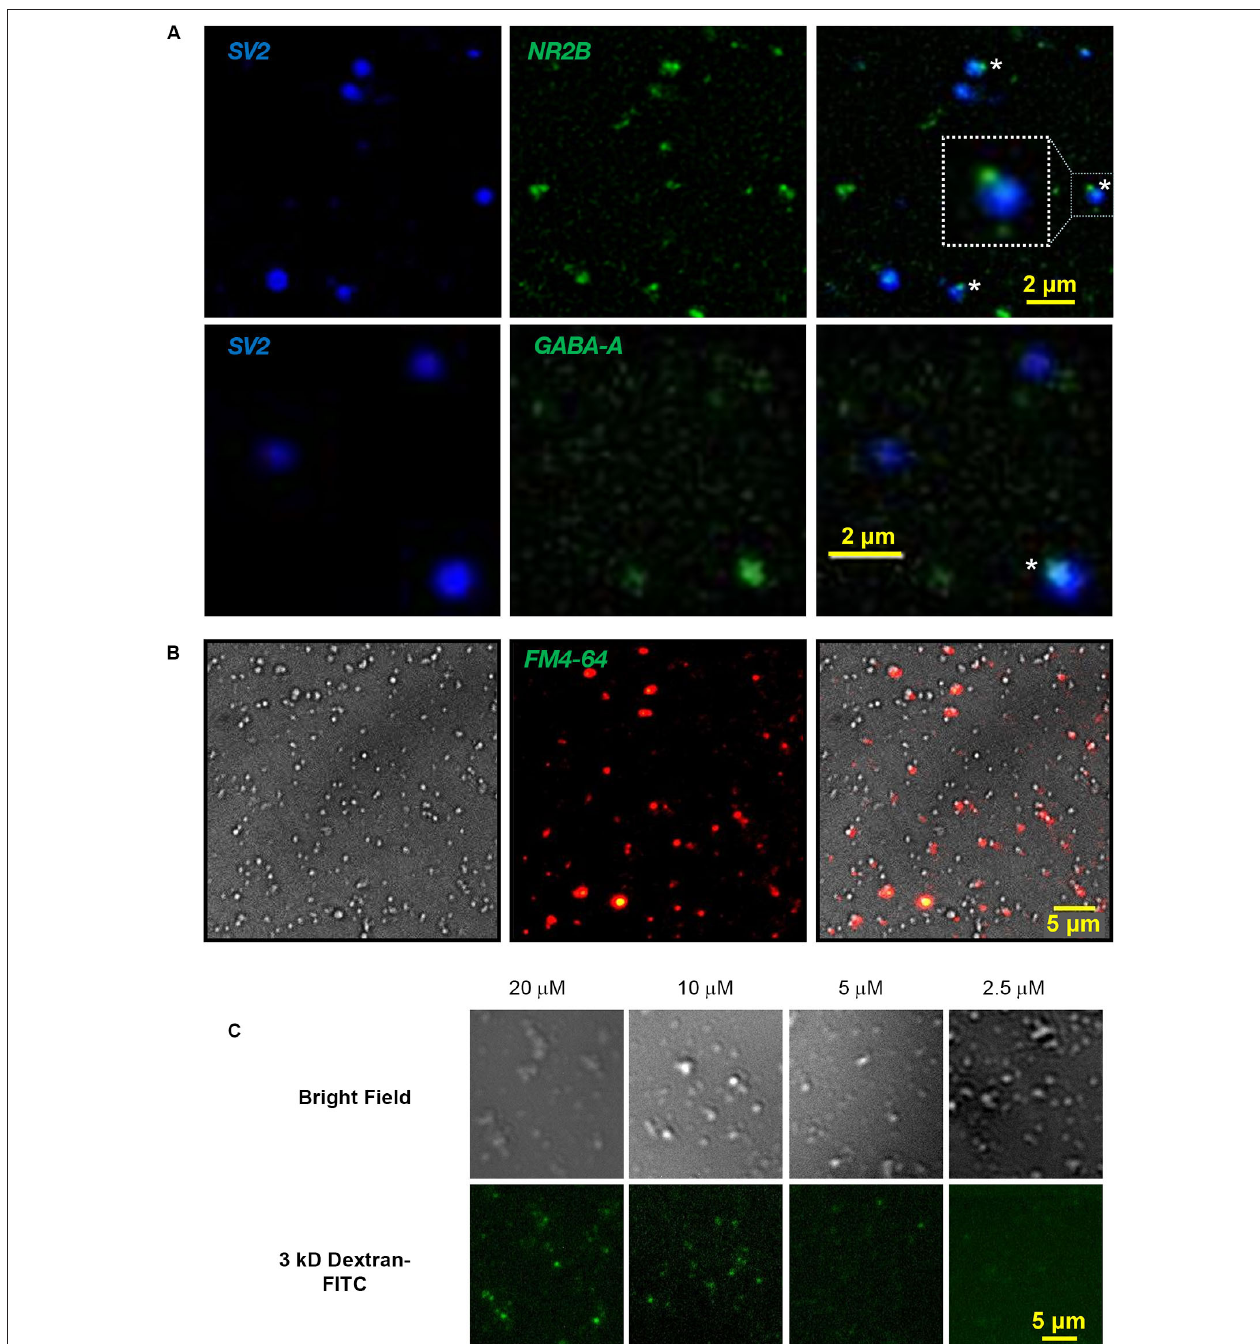
immersion, 1.45 NA objective. Image stacks used for fixed samples, as in A, were deblurred by iterative deconvolution using the Zeiss turnkey software, as described (Li et al., 2004). (B) Nomarski bright field (left) , FM4-64 uptake (2 mM Ca 2 + /40 mM K + ; center ) and overlay ( right ) identifying terminals with functional SV recycling in the SSM fraction. FM dye stained SSM images were background corrected using the Zeiss software function. (C) Chick synaptosomes cryoloaded with 3 kDa dextran-FITC with the marker at the indicated concentrations in the freezing buffer imaged by bright field ( upper panel ) and fluorescence microscopy ( lower panel